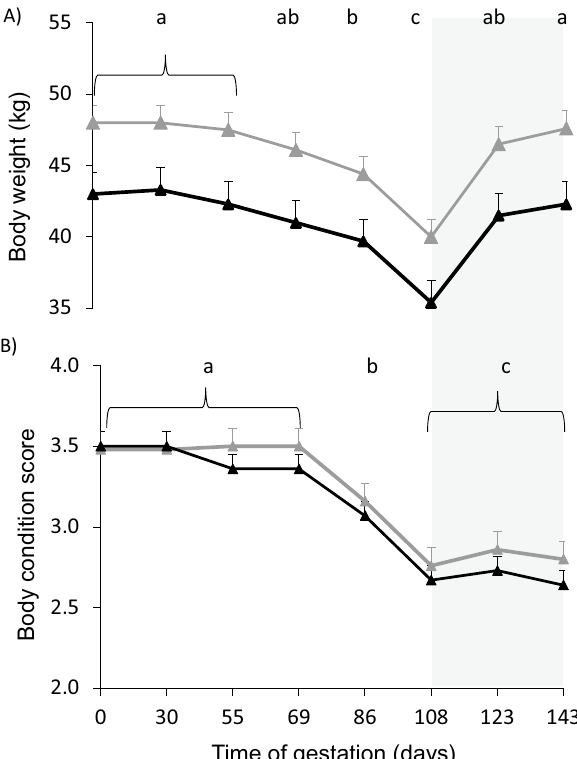
Figure 1. Body weight ( A ) and body condition score ( B ) of multiparous (gray filled triangle) and primiparous (black filled triangle) ewes. Body weight was greater and body condition score tended to be greater in multiparous than in primiparous ewes ( p < 0.0001 and p = 0.07, respectively). Different letters indicate significant differences between gestation days ( P < 0.0001). The light grey area represents the period when all ewes were supplemented with 300 g/animal/day of rice